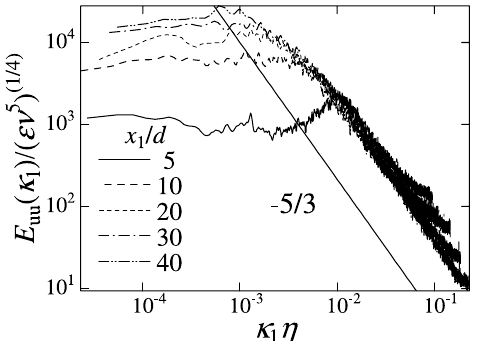
Fig. 15 Power spectra of fluctuating velocity on the centerline